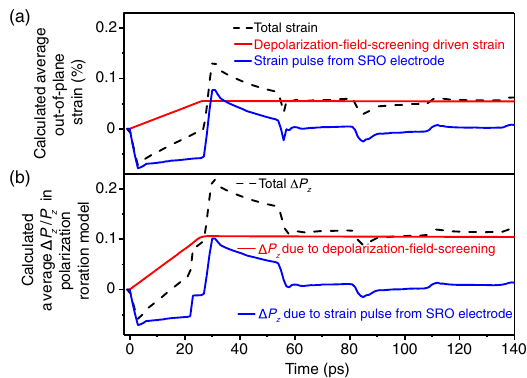
FIG. 4. Details of the polarization rotation model. (a) Simulated average out-of-plane strain in the SL, under conditions matching the experiment shown in Fig. 1(e). (b) Simulated total change in out-of-plane polarization, Δ P z , and separate contributions due to acoustic strain and depolarization-field-screening-induced